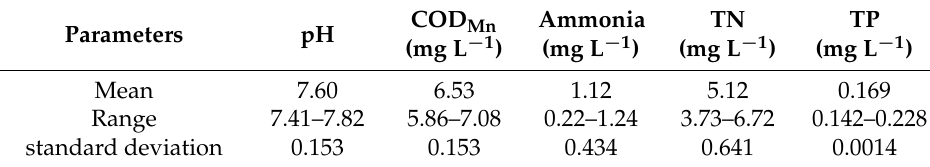
Table 1. Raw water quality of Huangpu River during